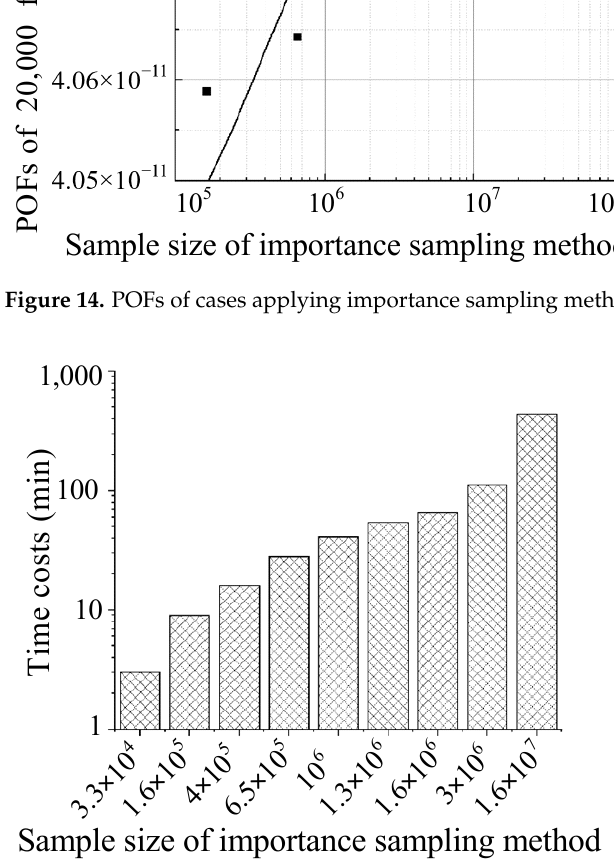
Figure 15. Time costs of cases applying importance sampling method.